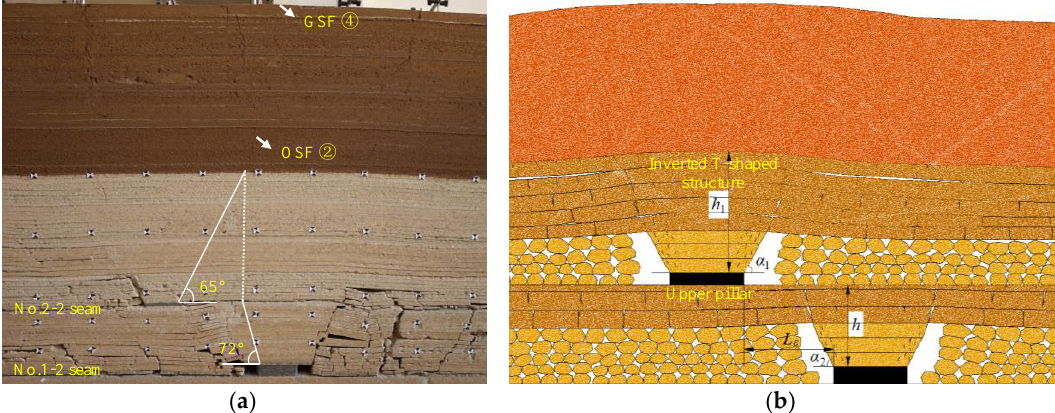
Figure 20. Model based on coupling control of displacement field and fracture field: ( a ) physical simulation model; ( b ) sketch model.